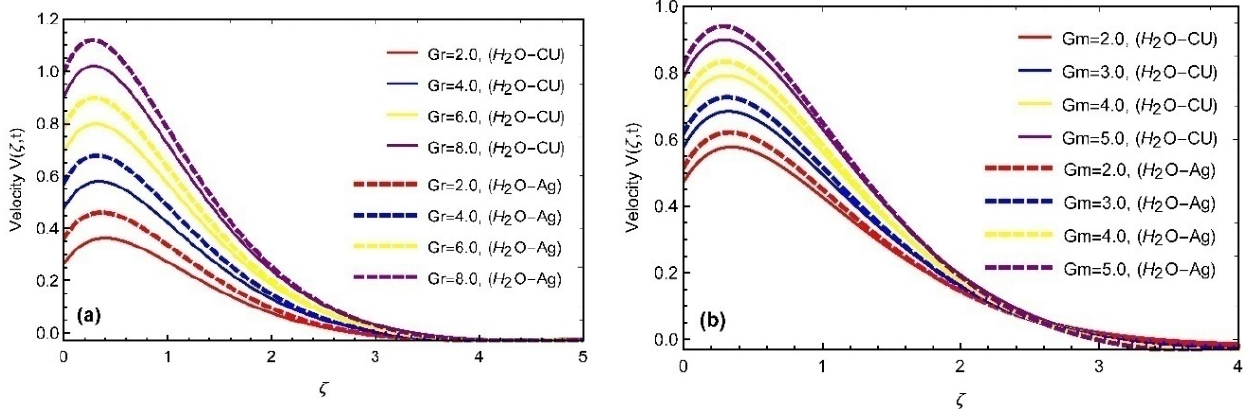
, 𝜑 = , 𝜑 = , 𝜑 = (cid:2871) , ϕ = 0.02, t = 1.0. (cid:2871) (cid:2871) 3